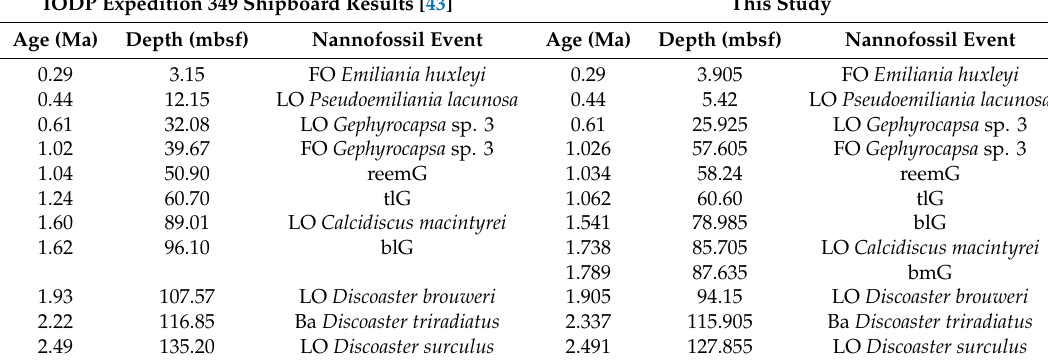
Table 1. Summary of calcareous nannofossil biostratigraphic events of [43] and this study for International Ocean Discovery Program (IODP) Expedition 349, Site U1431D. Age discrepancies from